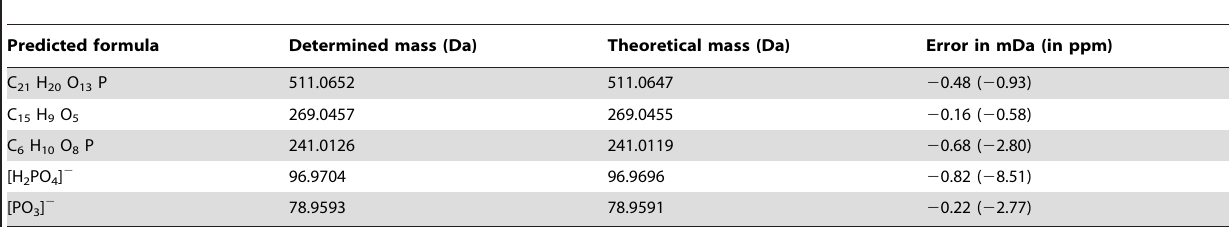
Table 1. Predicted formula, determined and theoretical mass/charge ratios as well as the mass error of fragment ions observed in the product ion mass spectrum of m/z